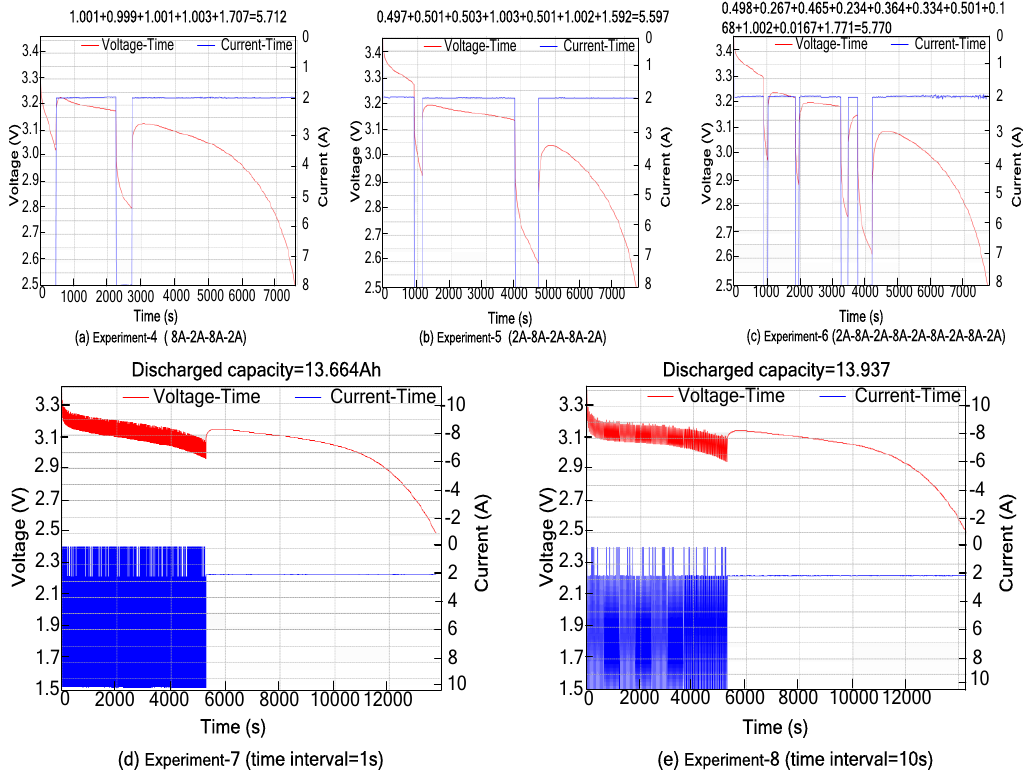
Figure 7. The discharge procedures with different discharging frequencies. ( a ) Experiment-4 (8A-2A-8A-2A); ( b ) Experiment-5 (2A-8A-2A-8A-2A); ( c ) Experiment-6 (2A-8A-2A-8A-2A-8A-2A-8A-2A); ( d ) Experiment-7 (time intervals = 1 s); ( e ) Experiment-8 (time intervals = 10